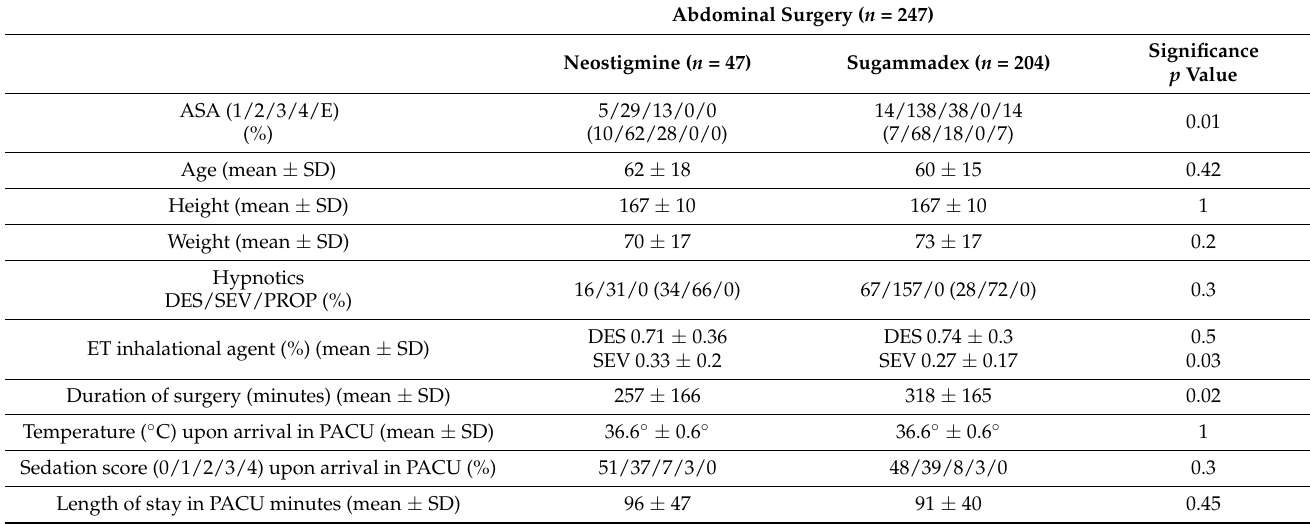
Table 2. Demographic characteristics for abdominal surgery